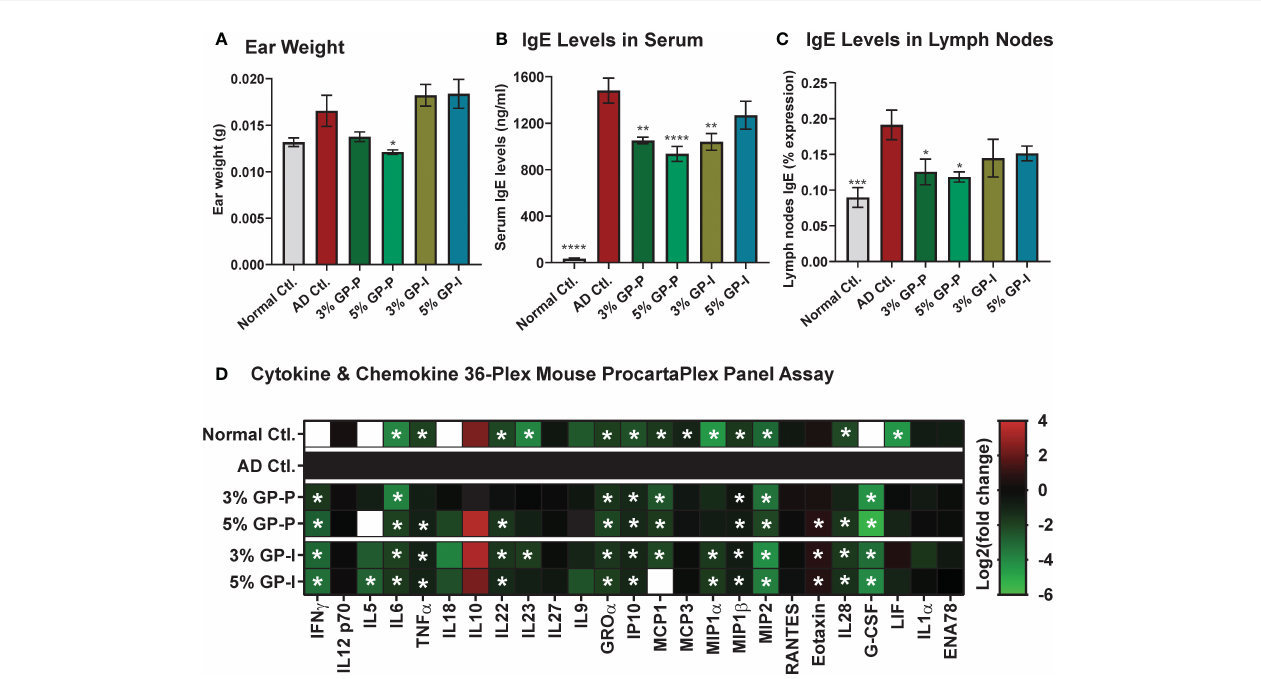
FIGURE 4 Effect of grape powder supplementation on the ear weight, lgE levels, and key cytokines and chemokines in atopic dermatitis. (A) At the time of tissue collection, three ear punches were obtained from each ear using a biopsy punch. Punches were weighed and averaged per animal. (B) Blood was collected by cardiac puncture after euthanasia, and serum was extracted. Serum levels of IgE were measured using ELISA. (C) Lymph nodes IgE was measured using Flow cytometry as described in ‘ Materials and Methods ’ section. (D) Serum cytokines and chemokines were measured using Cytokine & Chemokine 36-Plex Mouse ProcartaPlex Panel. The assays with serum were performed using a pool of 2 mice per sample in biological quadruplicate. Ear weight and IgE data are represented as mean ± SEM. ProcartaPlex Panel data are presented as Log2 (mean concentration of experimental groups (pg/ mL)/mean concentration of AD control). A one-way ANOVA with Dunnett ’ s multiple comparisons test was performed and represented as mean ± SEM with statistical signi fi cance compared to AD control (*p<0.05, **p<0.01, ***p<0.001,